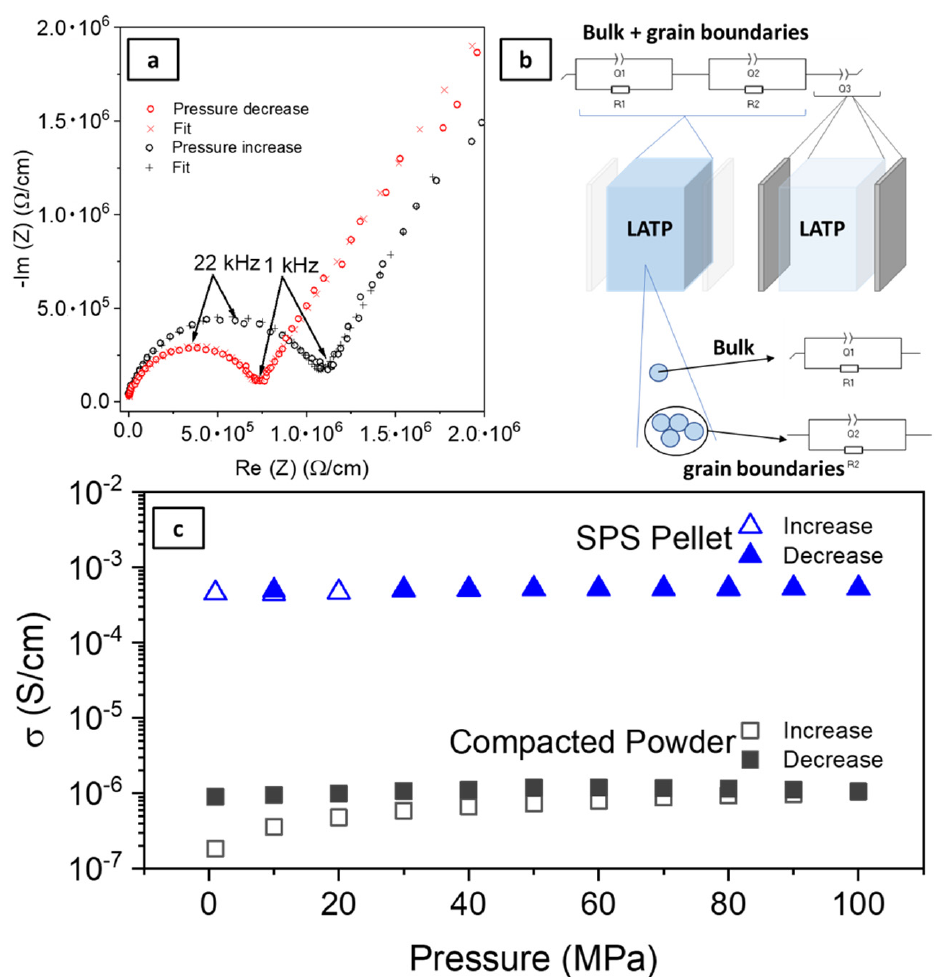
Figure 1. ( a ) Typical Nyquist diagrams at 60 MPa for LATP powders, ( b ) schematic representation of the EIS cell and the corresponding equivalent circuit, and ( c ) the evolution of the total ionic conductivities of LATP powder and LATP SPS pellet as a function of the applied pressure.